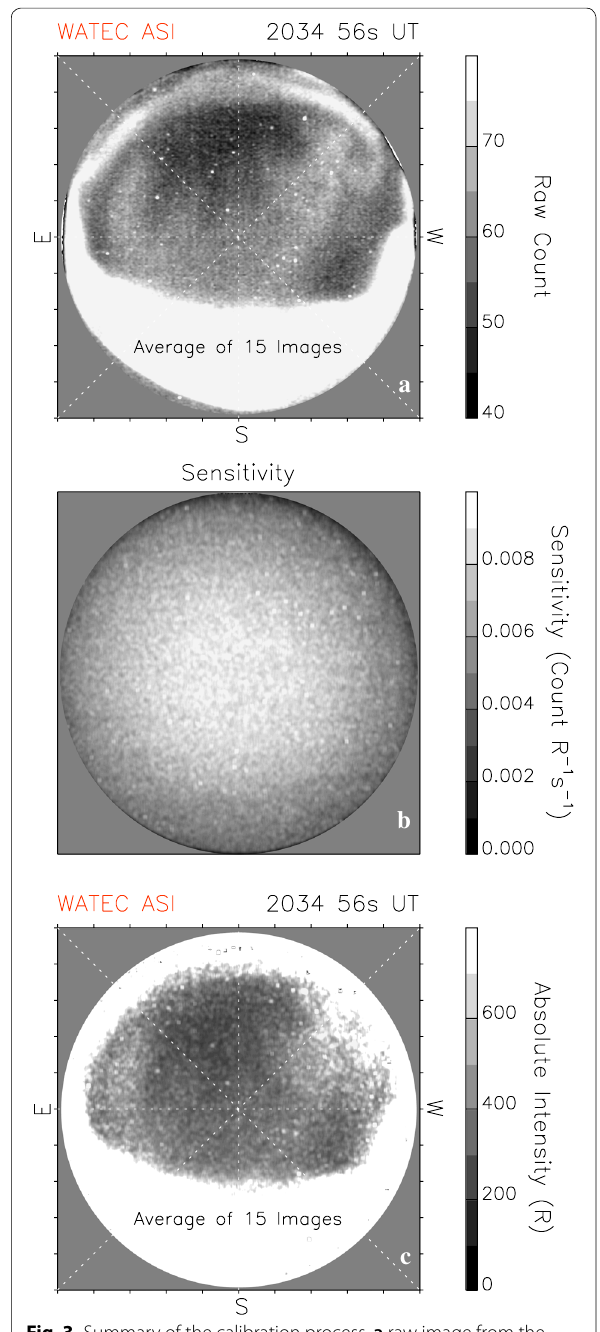
Fig. 3 Summary of the calibration process, a raw image from the WATEC ASI at around 20:35 UT on December 4, 2013, b sensitivity distribution of the WATEC ASI derived from a calibration using integrating sphere, and c absolute optical intensity image of the WATEC ASI at around 20:35